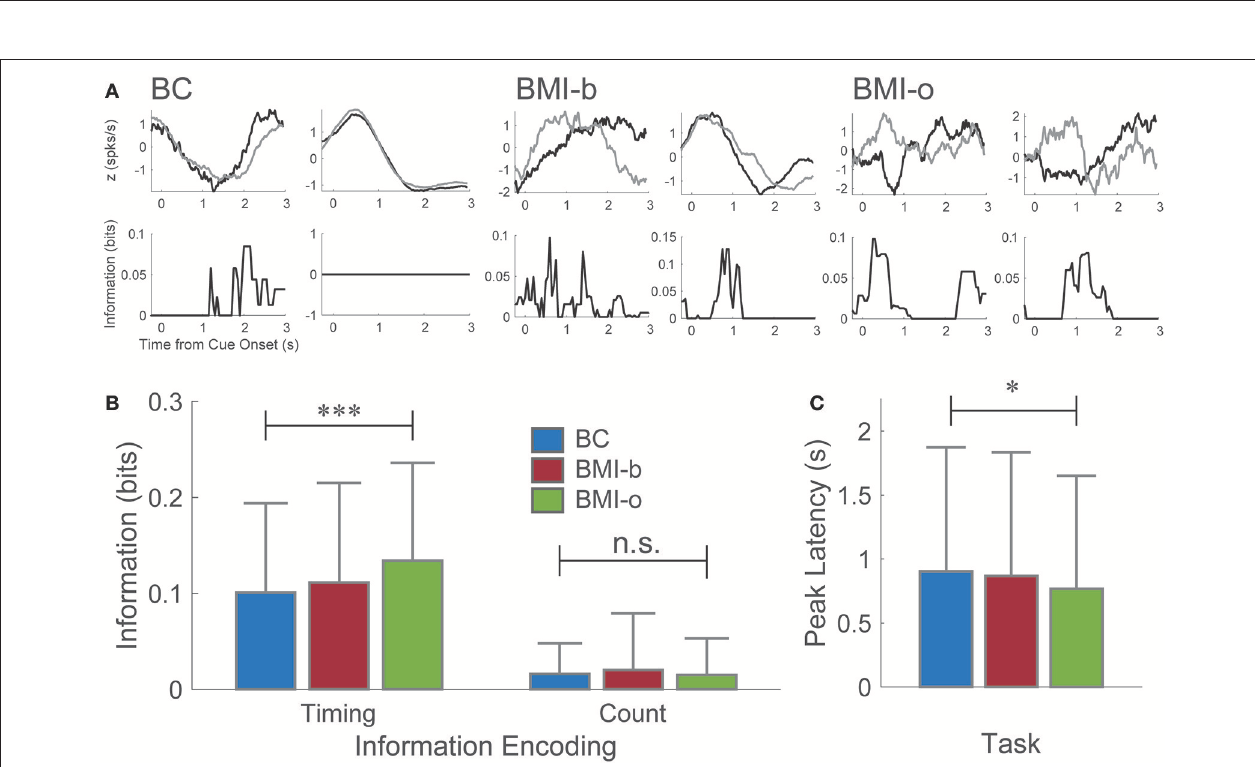
FIGURE 2 | Pre-injury tasks. (A) Example perievent histograms from the behavioral task and the pre-injury BMI tasks. Neurons recording during the behavioral task exhibited a wide range of responses from the time of cue onset. Here, one neuron maximally encodes information about press duration at longer latency ( ∼ 2s, short press ends, long press continues) while another neuron, although clearly modulated by the movement, encodes no information about press duration. For both pre-injury BMI tasks, information is encoded maximally at shorter and shorter latencies to cue-onset. (B) Neurons on average encoded significantly more information about press duration (spike timing) at significantly shorter latencies (C) as animals moved from behavioral control to BMI-o, while there was no change in spike count information. * p < 0.05; *** p < 0.001.